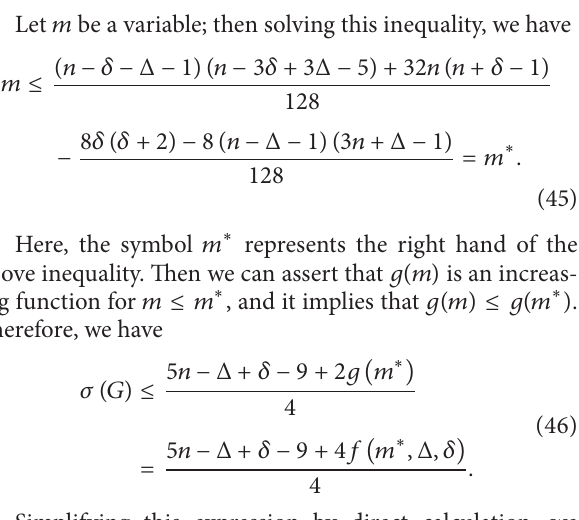
Figure 3: Graph of order